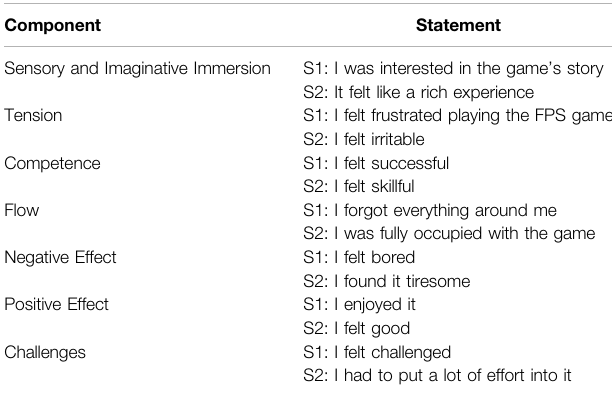
TABLE 5 | The third part of post-study questionnaire (GEQ) (IJsselsteijn et al., 2013). All questions were rated on a Likert scale (1 (cid:1) strongly disagree, 7 (cid:1) strongly